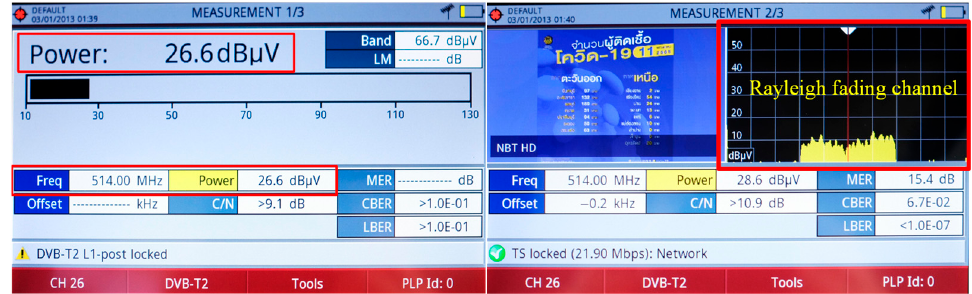
Figure 23. The indoor reception performance of the portable wideband directional antenna scheme.